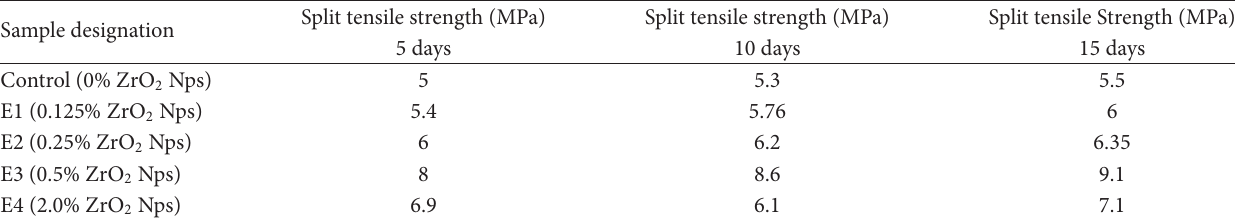
T 4: Flexural strength of cement modi�ed with ZrO 2 Nps.